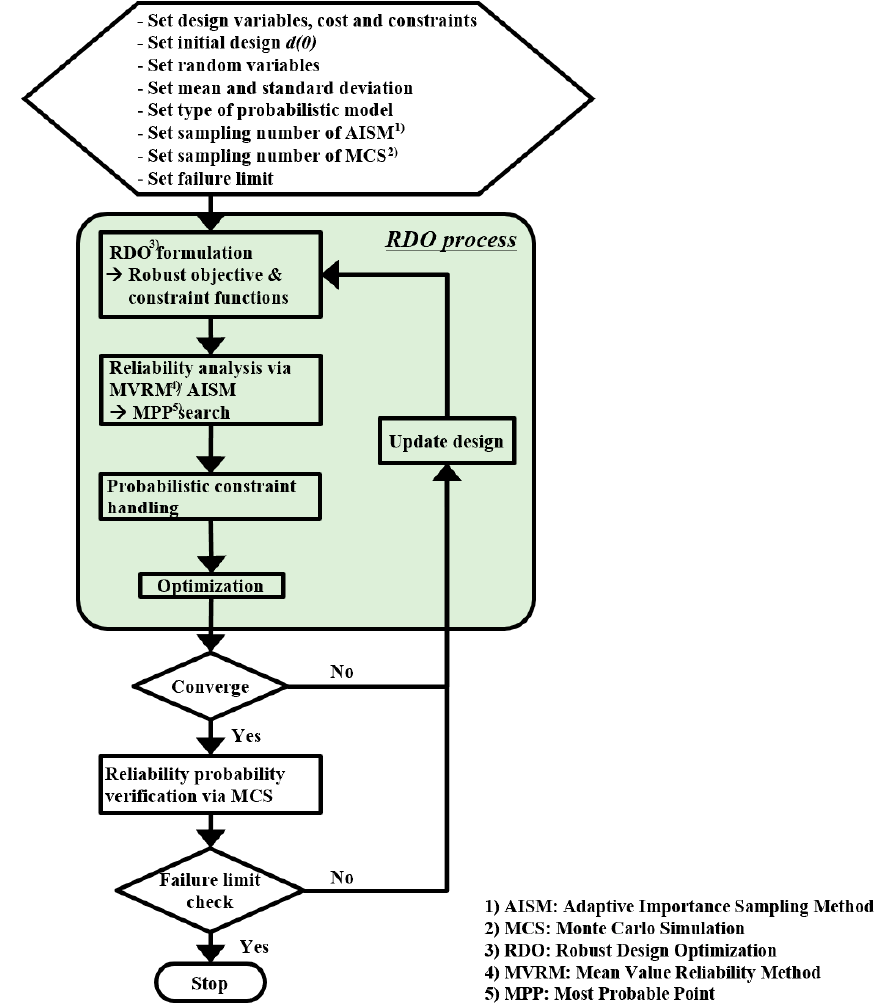
Figure 7. Enhanced RDO procedure.